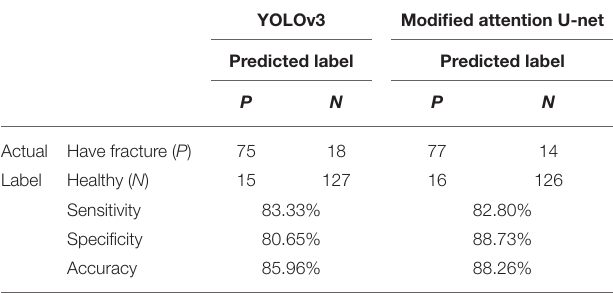
TABLE 2 | Skull fracture identification on the test